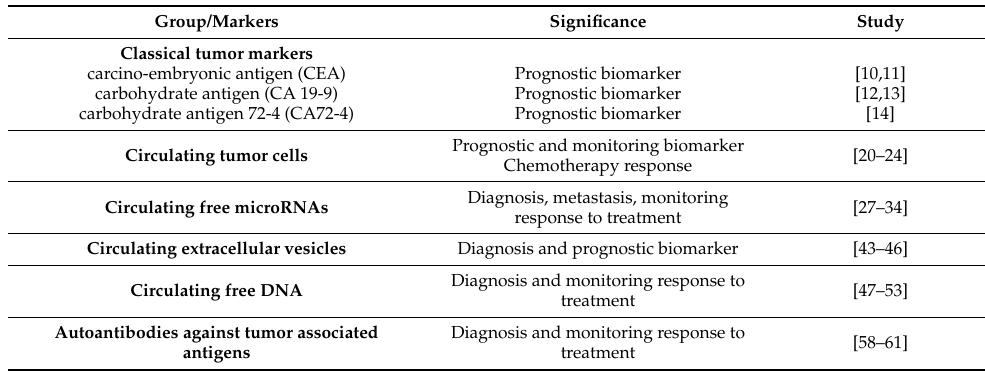
Figure 1. Division of gastric cancer markers. Table 1. Diagnostic performance of liquid biopsy in gastric cancer.